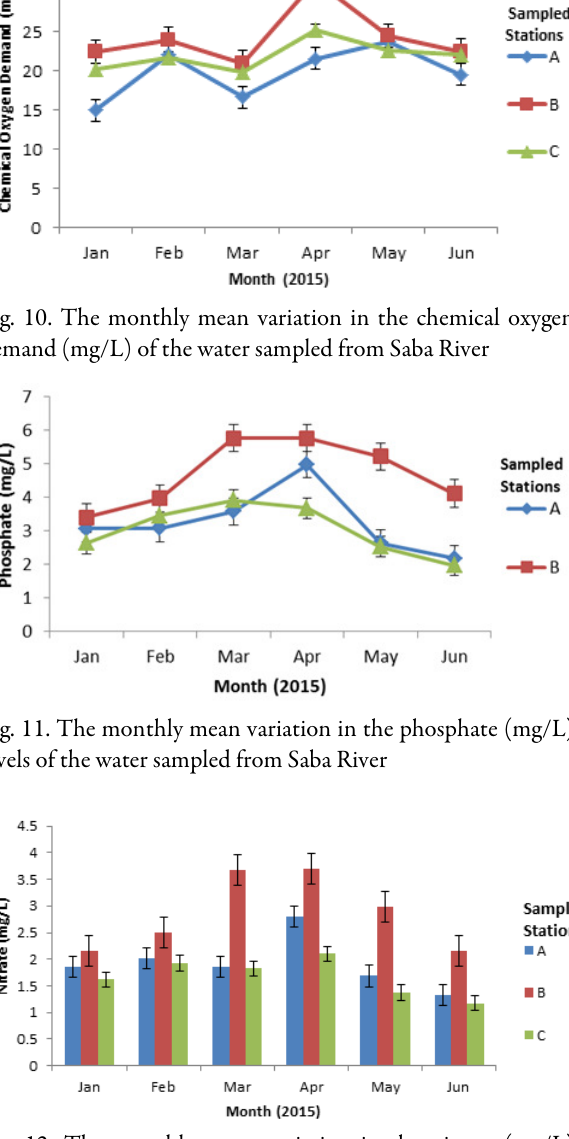
Fig. 12. The monthly mean variation in the nitrate (mg/L) levels of the water sampled from Saba